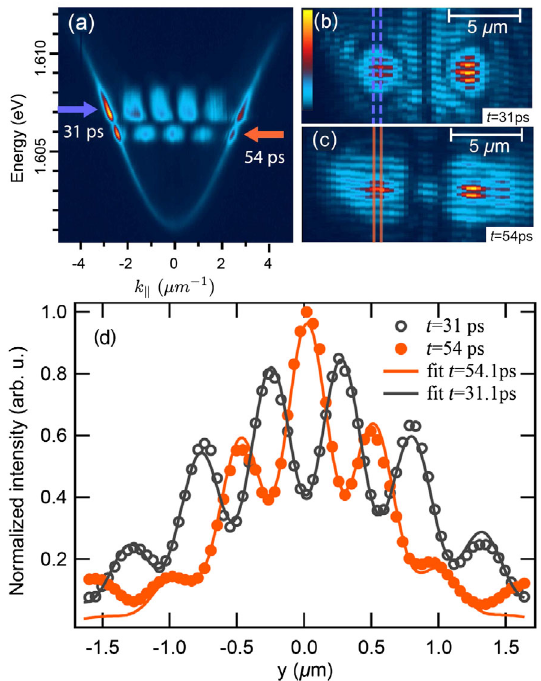
FIG. 4. (a) The time-integrated momentum space shows that condensation occurs at two distinctly different wave vectors. At t ¼ 31 ps (marked by a blue arrow), the polariton dyad is in antiphase synchronization. At t ¼ 54 ps (marked by an orange arrow), the polariton dyad is in in-phase synchronization. (b,c) Time-resolved interferograms at t ¼ 31 ps and t ¼ 54 ps, re- spectively, showing the phase synchronization of the two con- densates. The real-space scale bars in (b,c) apply to both horizontal and vertical directions. The color scale in (a – c) is shown as an inset bar in (b). The data in (a,b,c) are normalized. (d) The intensity profiles of the interferograms at the positions marked by the vertical lines in (b) (dashed blue) and (c) (solid orange) provide a direct experimental observation of the pi phase difference in the two synchronization regimes. The solid lines are the fits of a Gaussian function convoluted with a cos ð ky þ ϕ Þ , giving a phase difference of ð 0 . 98 (cid:1) 0 . 01 Þ × π between the two states. The zero of the horizontal axis is defined at the maximum of the intensity profile extracted from